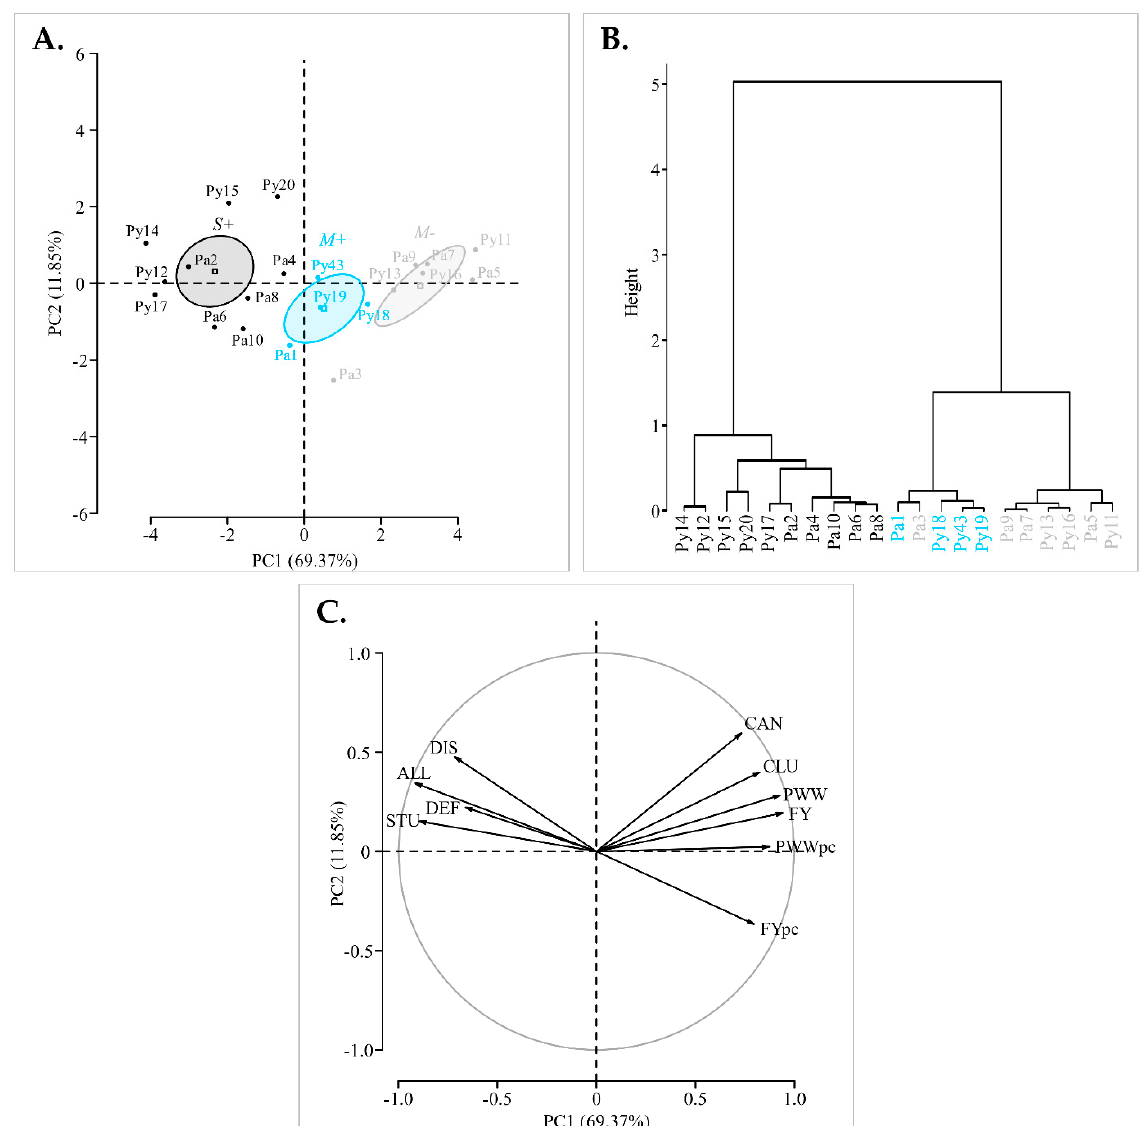
Figure 2. Principal components analysis (PCA) and hierarchical clustering of 21 vines according to their mean symptom scores and yield values over the four-year study (from 2016 to 2019). ( A ) Biplot representing the ‘M − ’ (grey), ‘M+’ (cyan) and ‘S+’ (black) individuals. Projection of M − , M+ and S+ categories are represented by squares with their confidence ellipses (95%). ( B ) Dendrogram representing the hierarchical clustering based on the individuals coordinates on the 10 principal components. ( C ) Loading biplot, the vectors show the relative importance of each variable in discriminating amongst the observations. Longer vectors indicate greater contribution. Vectors point in the direction they ordinate the observations (DIS: Leaf discolouration, DEF: leaf